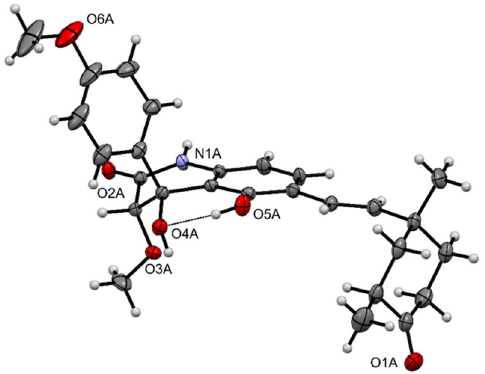
Figure 8. ORTEP view of the crystal structure of 11 (30% probability